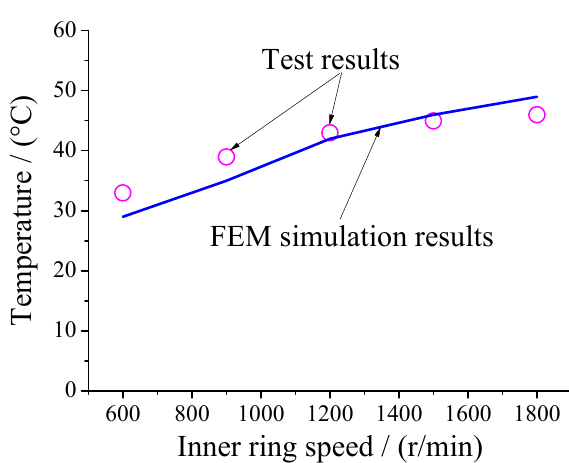
Figure 17. Comparison between the tested and FEM simulation values of temperature under different inner ring speeds (radial load: 400 N, kinematic viscosity: 15 cSt).